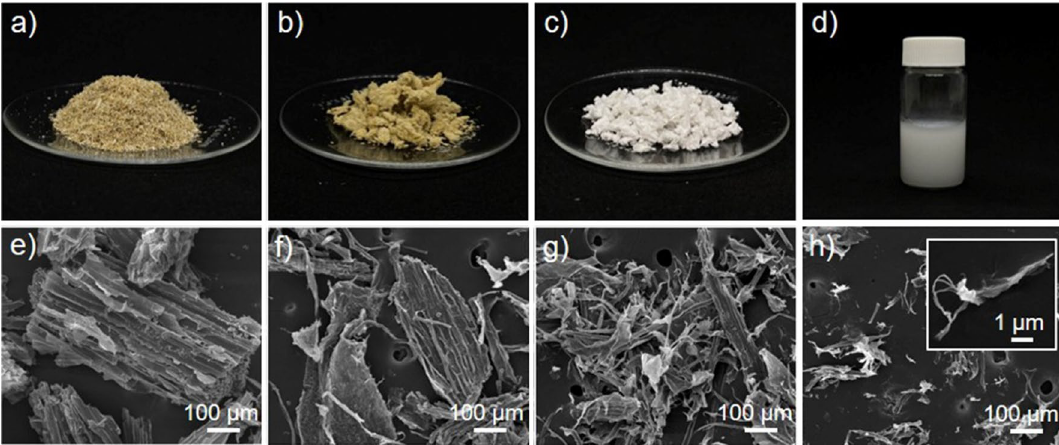
Figure 1. Photographs and SEM images; ( a , e ) raw Napier grass stems, ( b , f ) alkali-treated sample, ( c , g ) bleached sample, and ( d , h ) XCNC